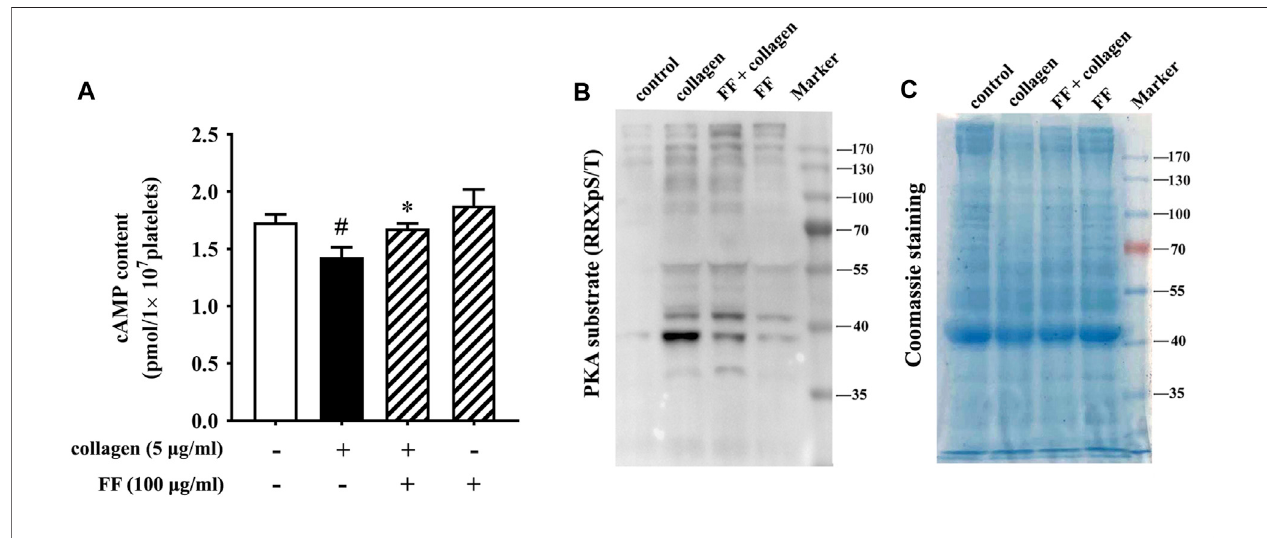
FIGURE 5 | Fruit fl ow recovered cAMP levels and reduced the phosphorylation of PKA substrates in collagen-stimulated platelets. (A) Analysis of cAMP levels by ELISA. (B) WesternblotanalysisofthephosphorylationofPKAsubstrates. (C) Coomassiestainingshowedthatproteinabundancewasequal.Thedatarepresent three